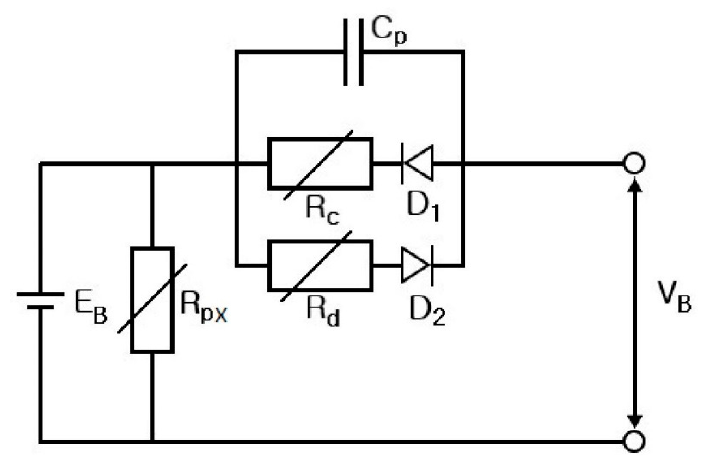
Figure 3. Improved battery model [3,4].